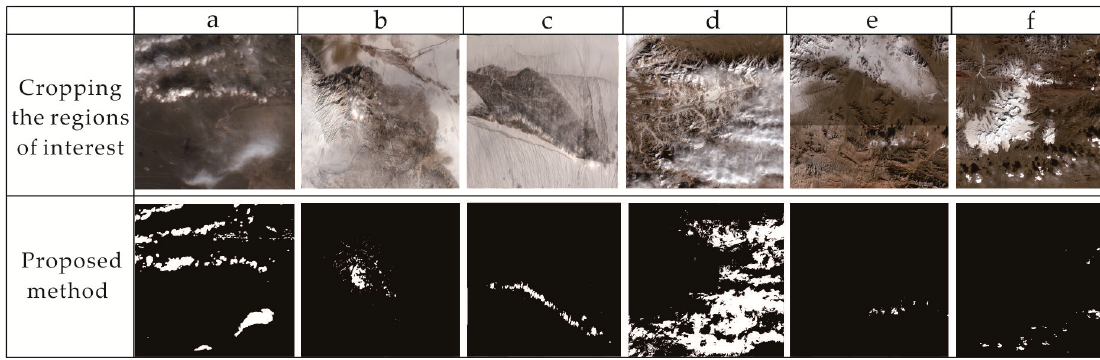
Figure 11. Enlarged view of the six indicated areas of detail in Figure 10, ( a – f ) correspond to the six regions of interest in Figure 10.